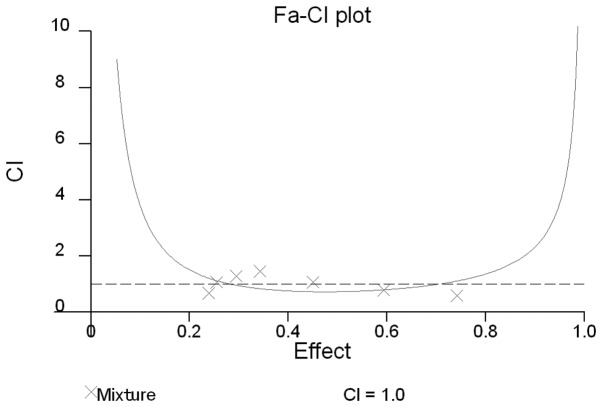
Combined effects of puerarin and 5-FU on the hepatocellular carcinoma cell line, SMMC7721. The CI values were determined using the method described by Chou and Talalay (18,19). CI=1, cumulative effect; CI<1, synergistic effect; and CI>1, antagonistic effect. The CI values for puerarin and 5-FU were <1 when the fractions affected were between 0.2555 and 0.7420. Thus, at specific concentrations, puerarin and 5-FU exhibit a synergistic inhibitory effect on the proliferation of SMMC7721 cells. 5-FU, 5-fluorouracil; CI, combination index.